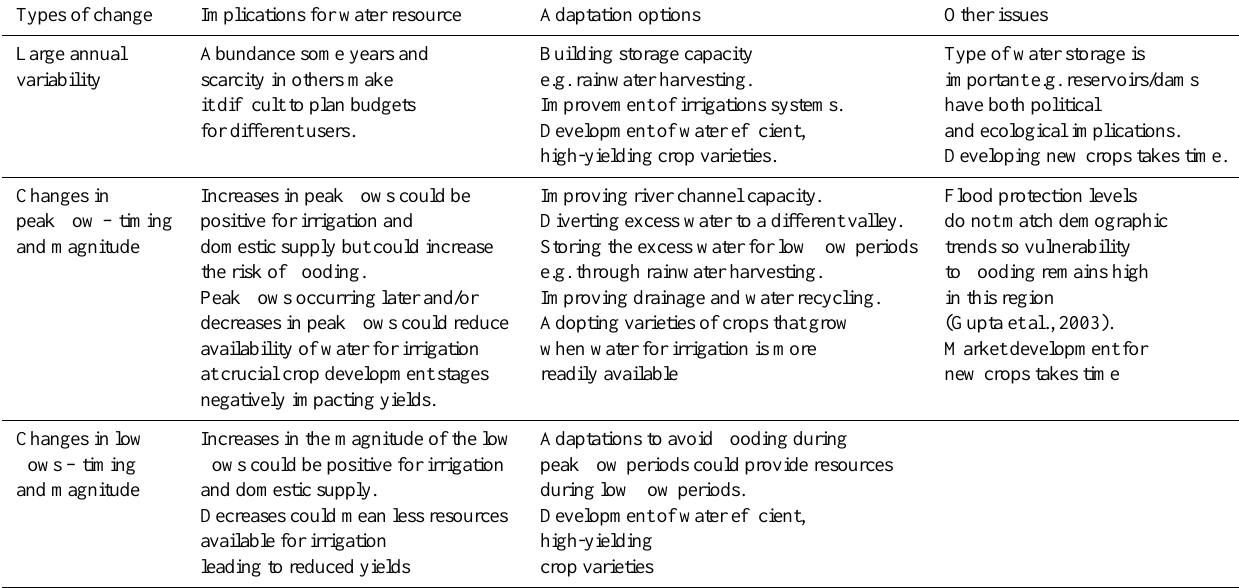
Table 3. Table of implications of changes in water